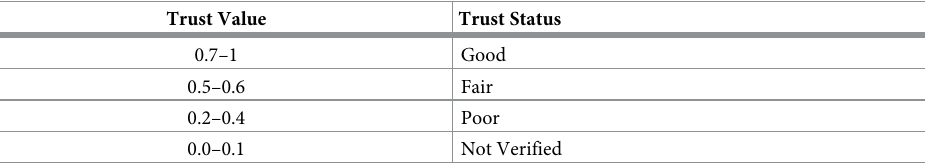
Table 3. Nodes’ rating based on trust